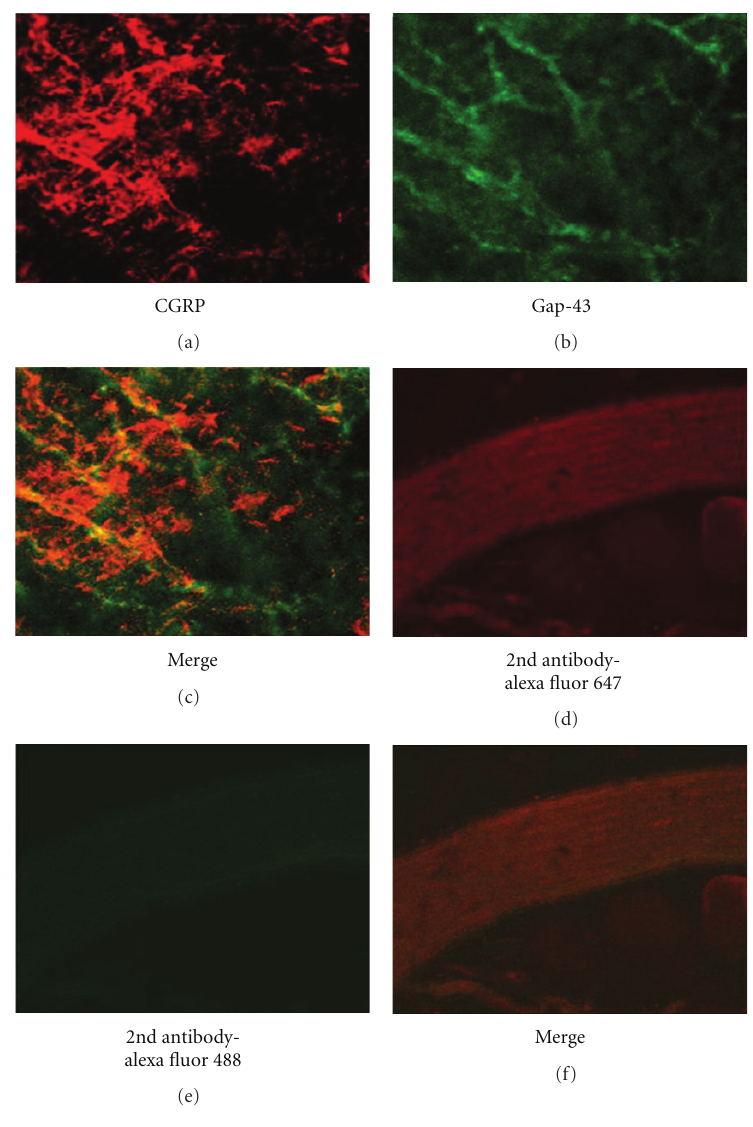
Figure 3: Immunofluorescent confocal analysis of the whole mount rat MBA expressing CGRP (in red, alexa fluor-647), Gap-43 (in green, alexa fluor-488), and the coexpression of these two markers (yellow). ANNIES and the nerve fibers strongly express CGRP (100%), and Gap-43. (Representative of 3